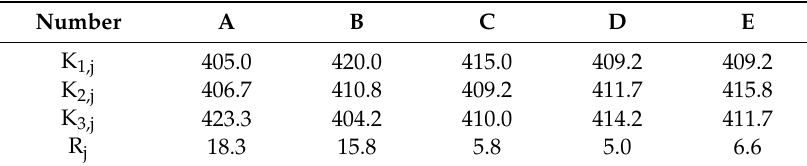
Table 16. Range analysis of slump flow test